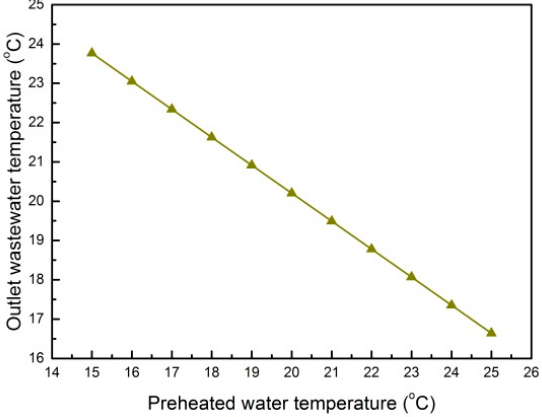
Figure 12. Influence of preheated water temperature on outlet wastewater temperature.